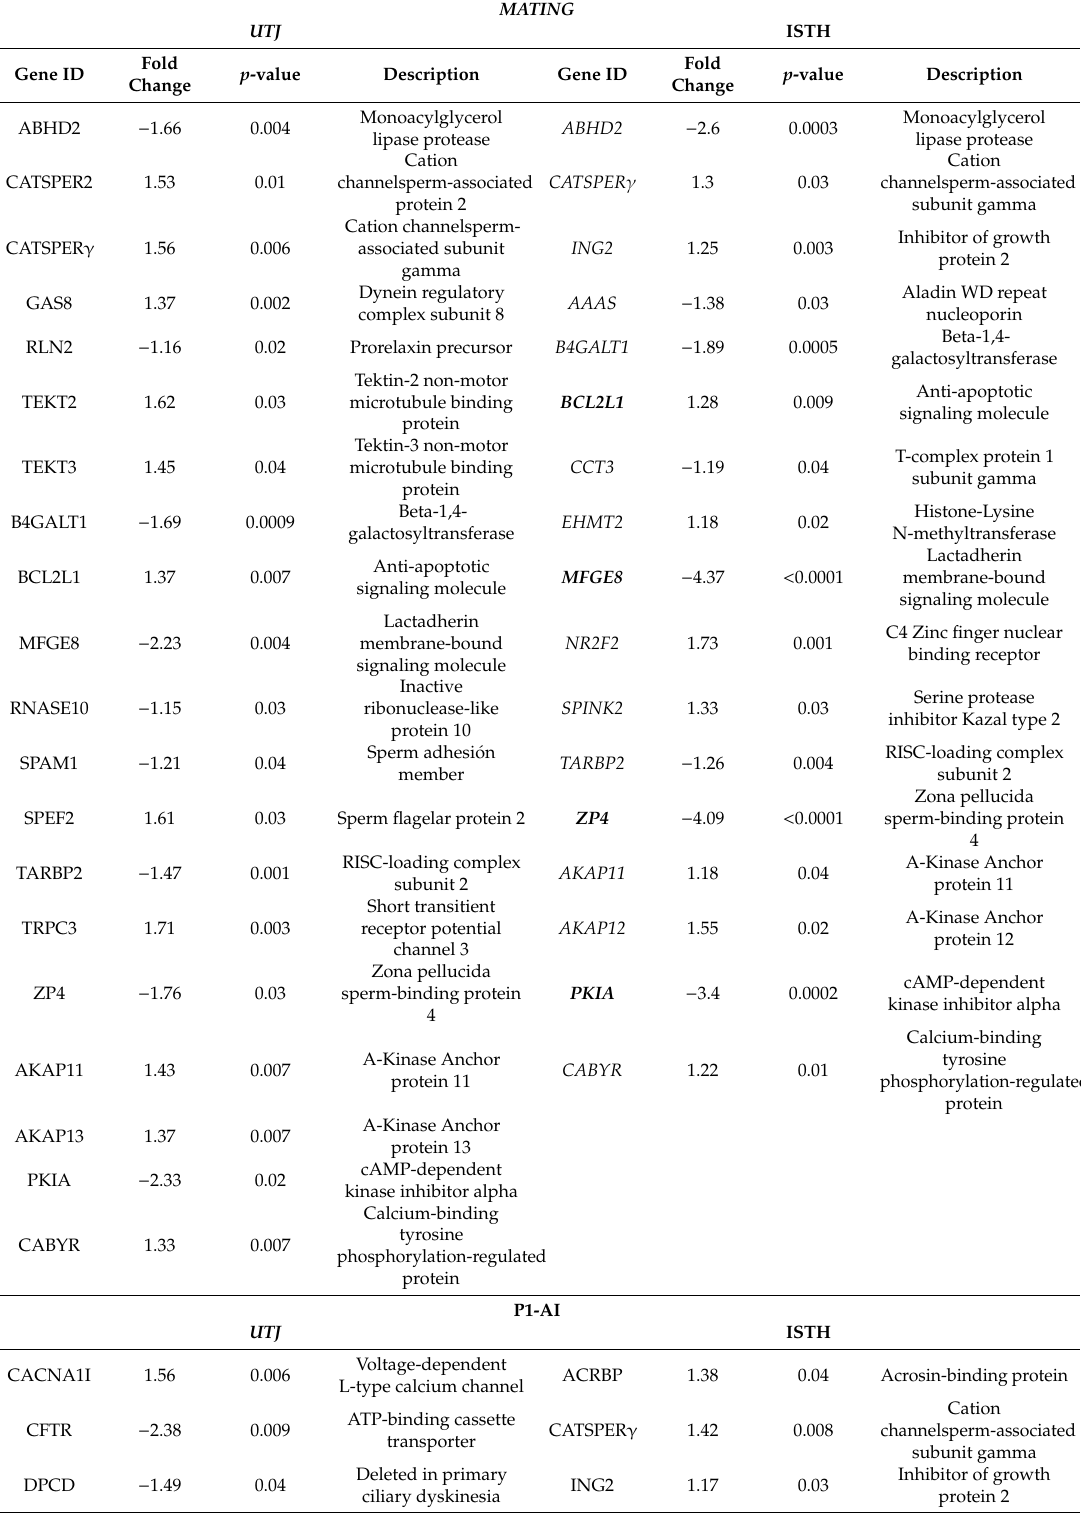
Table 1. Subset of altered transcripts potentially involved in sperm capacitation and / or fertilization in UTJ and Isth segments of the oviduct 24 h after mating or